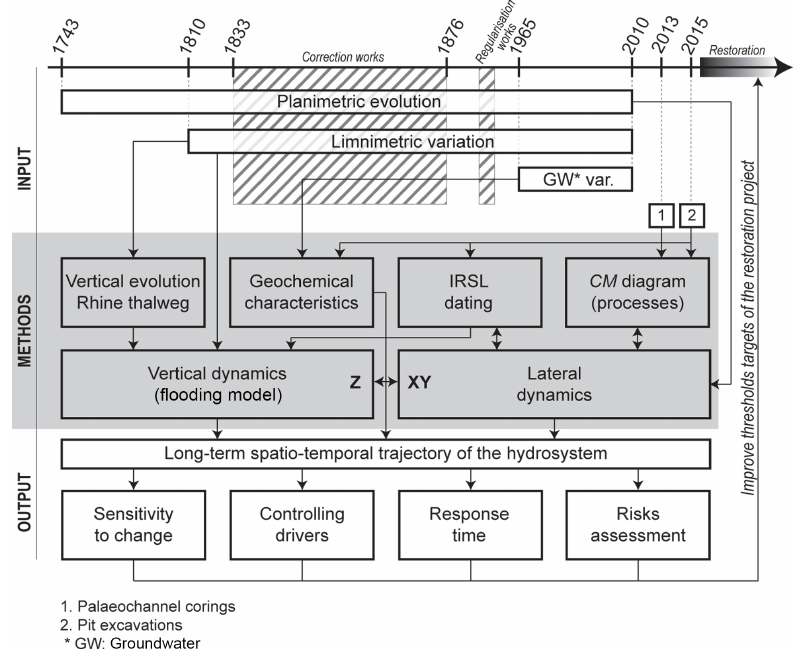
Figure 2. Methodological approach to analyse the long-term spatio-temporal trajectory of the hydrosystem by combining historical multi- source data with in situ morpho-sedimentary prospections and geochemical